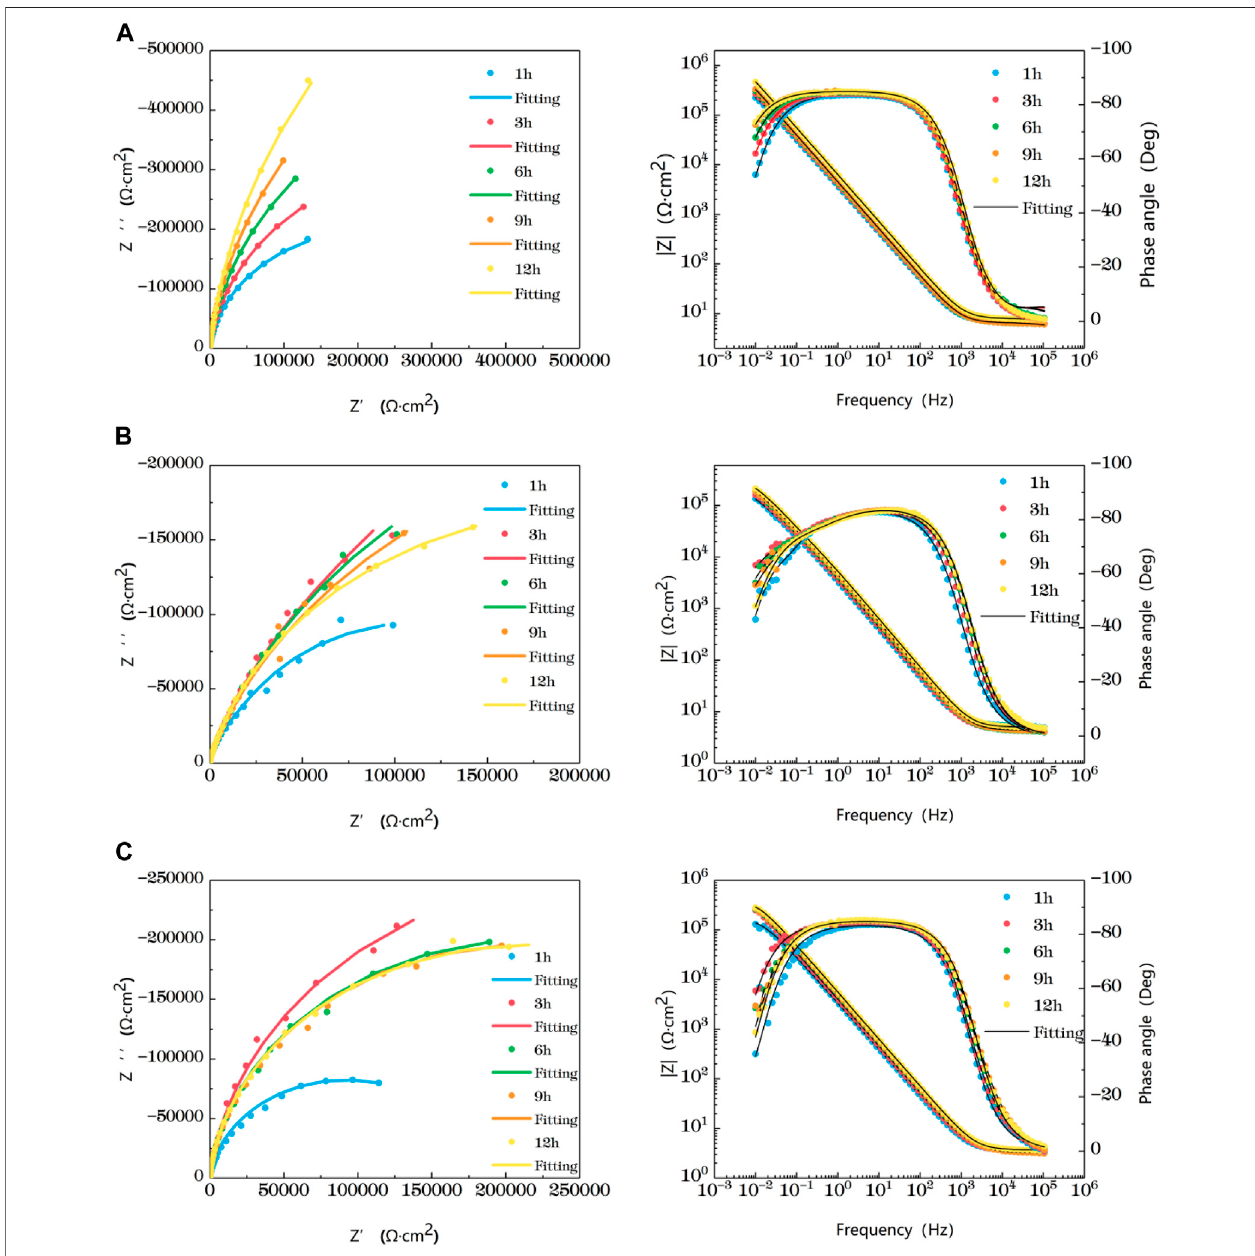
FIGURE 5 | Impedance change of weld zone soaked in arti fi cial seawater at different temperatures for 12 h (A) 25 ° C (B) 35 ° C (C) 45 ° C.